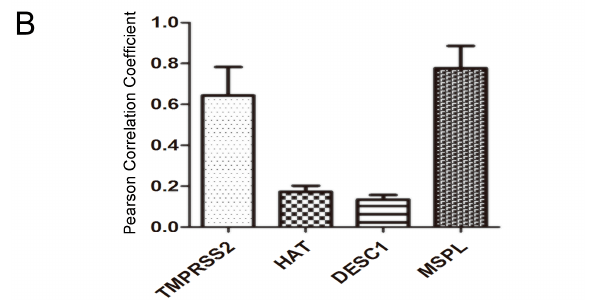
Figure 4. Analysis of TTSP and PEDV S protein co-localization. ( A ) Analysis of TTSP and PEDV S protein co-localization using a laser scanning microscope. Bar = 20–25 µ m. Magnification, ×400; ( B ) The co-localization of TTSPs and S protein was determined by calculation of Pearson correlation coefficient (PCC). The average PCC measured for three to five cells from separate experiments is shown; error bars indicate the standard errors of the means.